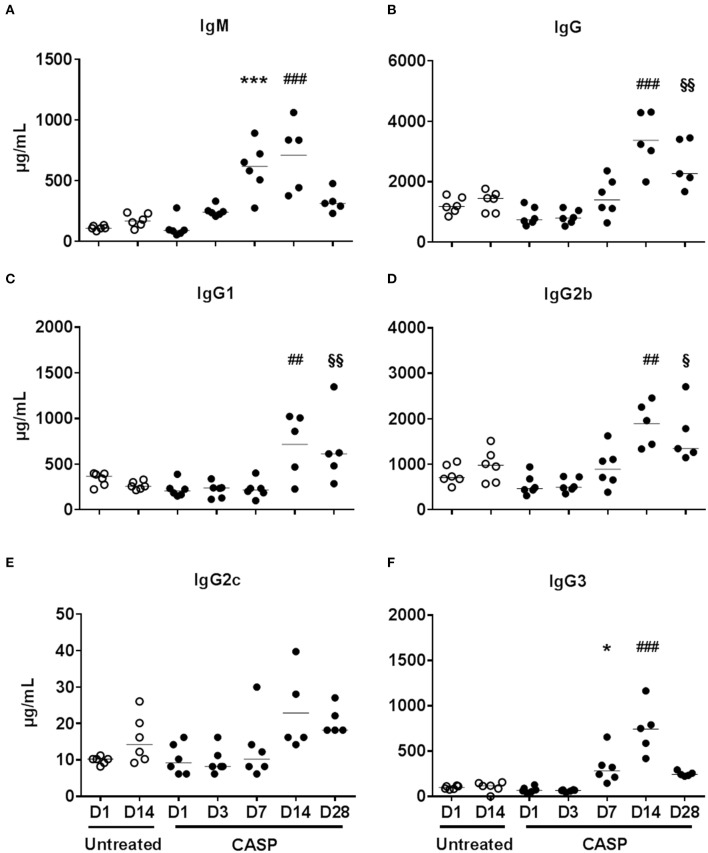
Serum immunoglobulin concentrations during the course of sepsis. Sepsis was induced by CASP-operation in female C57BL/6 mice. Untreated animals served as controls. At the indicated time points animals were anesthetized and blood was collected. Serum IgM (A) and IgG (B) concentrations, as well as the concentrations of all IgG-subtypes (C-F), were measured by Luminex®-technology. One of two similar experiments is shown here. We used the One Way ANOVA and Bonferroni post hoc test for selected pairs for statistical evaluation, and the mean is depicted in this figure. Significances are shown as number of symbols. one symbol p < 0.05; two symbols p < 0.01; three symbols p < 0.001. (*) CASP D7 vs. untreated D1, (#) CASP D14 vs. untreated D14, ($) CASP D28 vs. untreated D14; N = 5-6/group. The 95% confidence intervals of the differences of means are given in Supplementary Tables 1, 2.